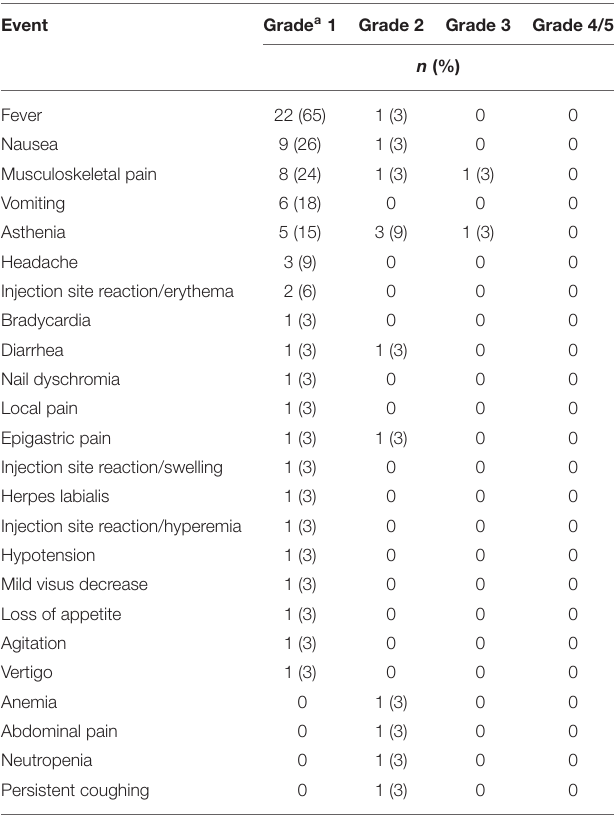
TABLE 2 | Treatment-related adverse events. TABLE 3 | Nausea and vomiting in the different treatment